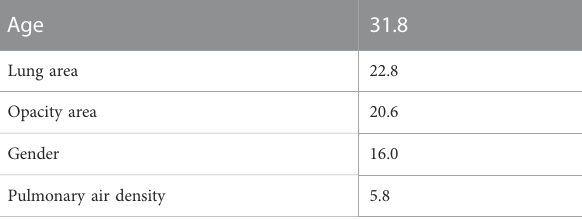
TABLE 4 Relative importance (%) of the variables in the total cohort of COVID- 19 patients based on SHAP values.